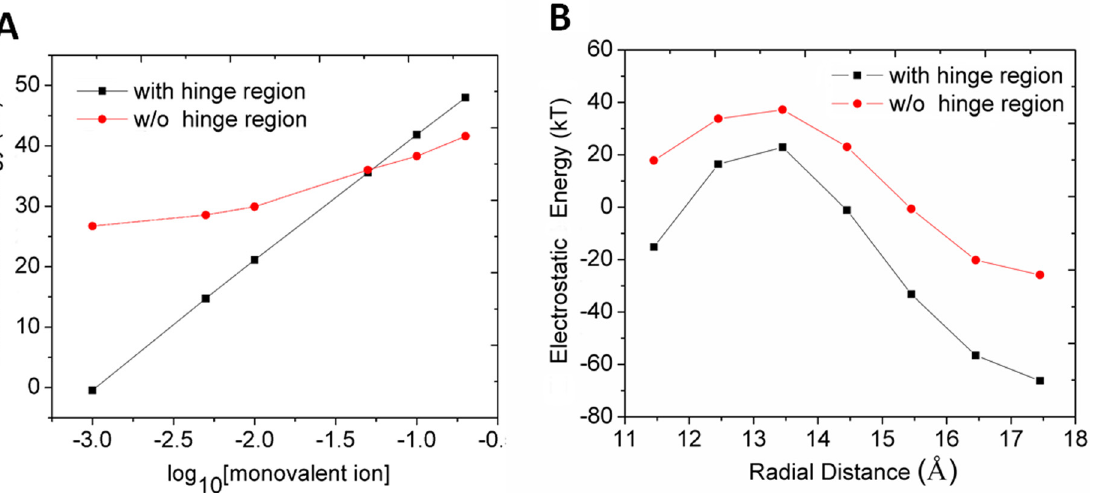
Fig 3. The electrostatic energy of nonspecific LacI Δ 1-62/DNA and LacI Δ 1-49/DNA. (A) The electrostatic energy as a function of salt concentration. (B) The electrostatic energy in pure water as a function of radial distance.